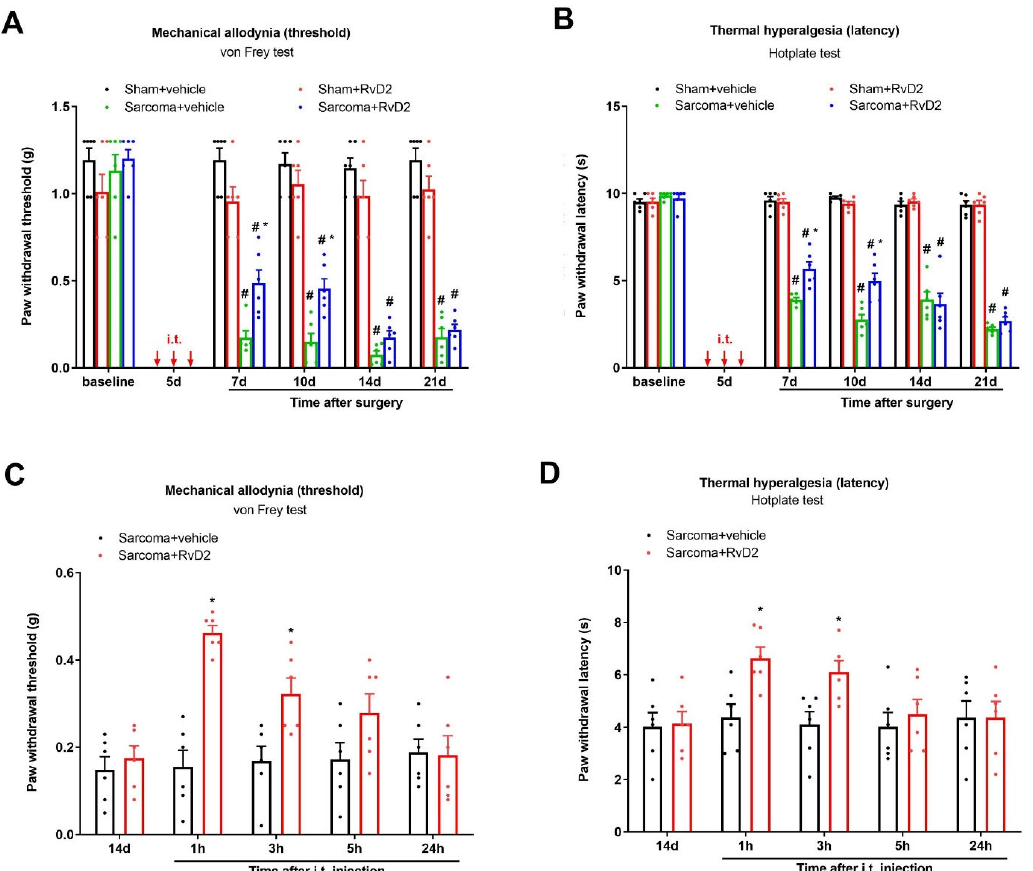
Figure 3. Intrathecal treatment with RvD2 reduced the production and persistence of bone cancer pain following sarcoma cell implantation. ( A , B ) Intrathecal (i.t.) RvD2 (500 ng) was given daily on days 4, 5 and 6 (indicated by red arrows) following sham and sarcoma implantations. ( C , D ) RvD2 (i.t., 500 ng) was injected on day 14 following sarcoma implantations. Mechanical allodynia was evaluated by paw withdrawal threshold ( A , C ) using von Frey experiments, and thermal hyperalgesia was evaluated by paw withdrawal latency ( B , D ) using hotplate experiments. Results from behavioral testing are expressed as the mean ± SEM ( n = 6) and compared using two-way ANOVA followed by Bonferroni multiple comparisons. # p < 0.05 vs. group sham + vehicle. * p < 0.05 vs. group sarcoma + vehicle.